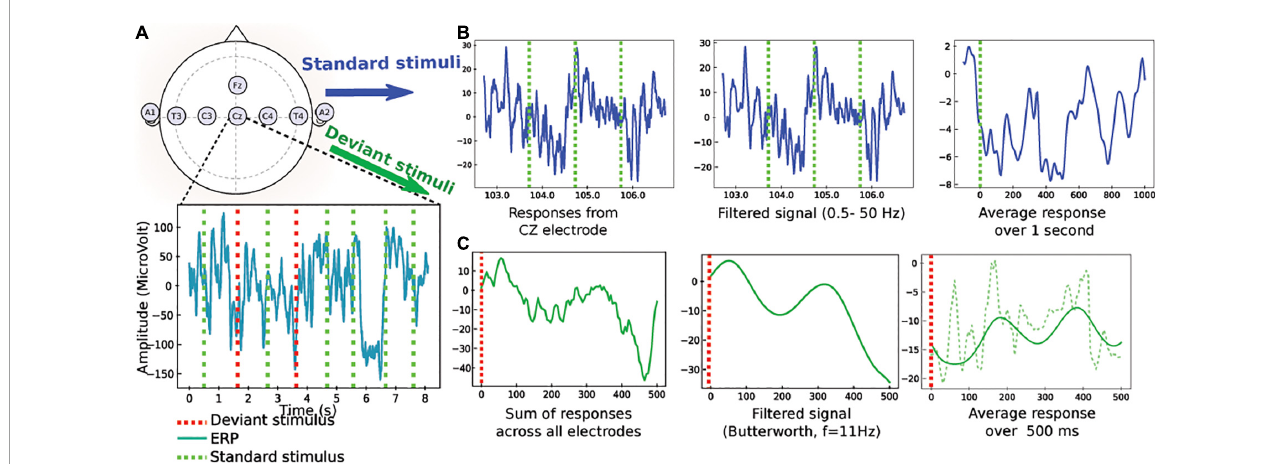
FIGURE1 Pre-processing of the evoked auditory responses to standard and deviant stimuli (an example of data obtained from the CZ electrode is given for standard stimuli and an example from all electrodes is given for deviant stimuli). (A) Upper: standard position of the EEG electrodes. Lower: EEG traces during a protocol mixing standard (green) and deviant (red) stimulations. (B) Sample of standard stimuli (blue) the EEG signal from CZ-electrode is filtered 0.5–50 Hz. The output is an average filtered response over 1 s. (C) Pre-processing of deviant stimuli: (1) the signal is summed over electrodes, (2) a low-pass filter is applied (butterworth with n = 2, cutoff frequency at 10 Hz), (3) average filtered response (continuous green) in a window of 500 ms to a deviant stimulus, computed after synchronization to the stimulus. The non-filtered average response is also shown (dashed